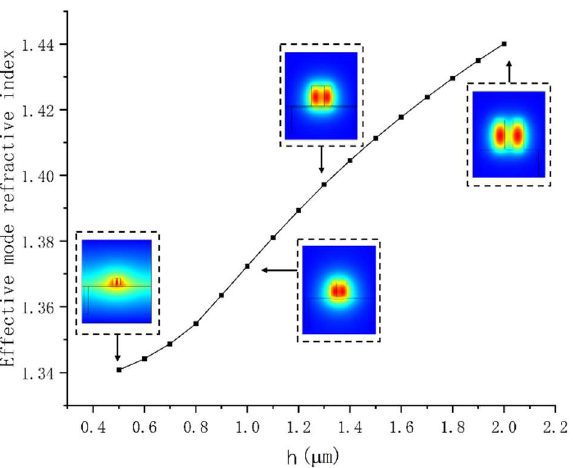
Figure 2. The 𝑁 (cid:3032)(cid:3033)(cid:3033) as functions of h for the section dimension as 2 µm × 2 µm. Insets: the distribu- tion of the optical fields when h = 0.5 µm, h = 1.0 µm, h = 1.3 µm, and h = 2.0 µm,